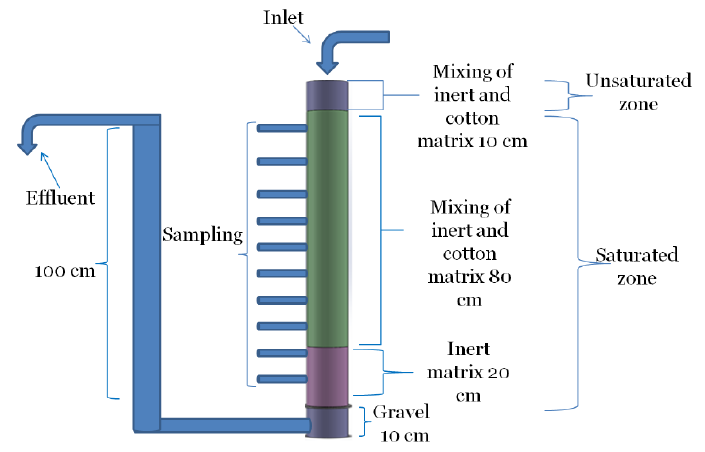
Figure 1. Scheme of the biofilter system.